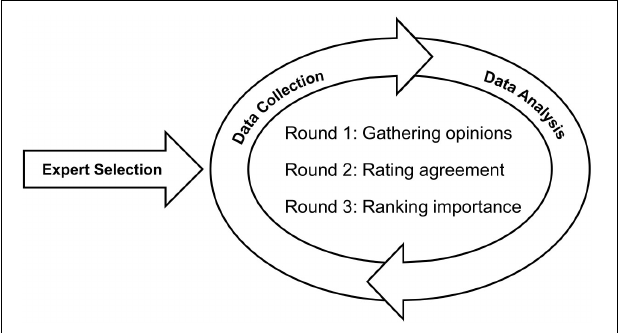
FIGURE 1 | Schematic representation of the three-round, ranking-type Delphi